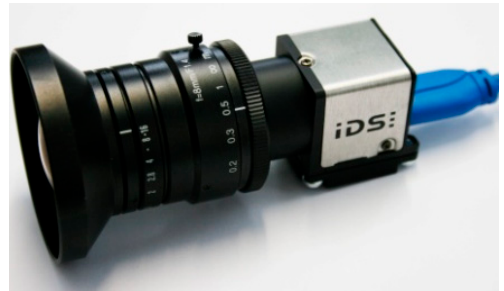
Figure 3. IDS camera UI337, resolution: 1024 by 1024 pixels at 100 Hz.